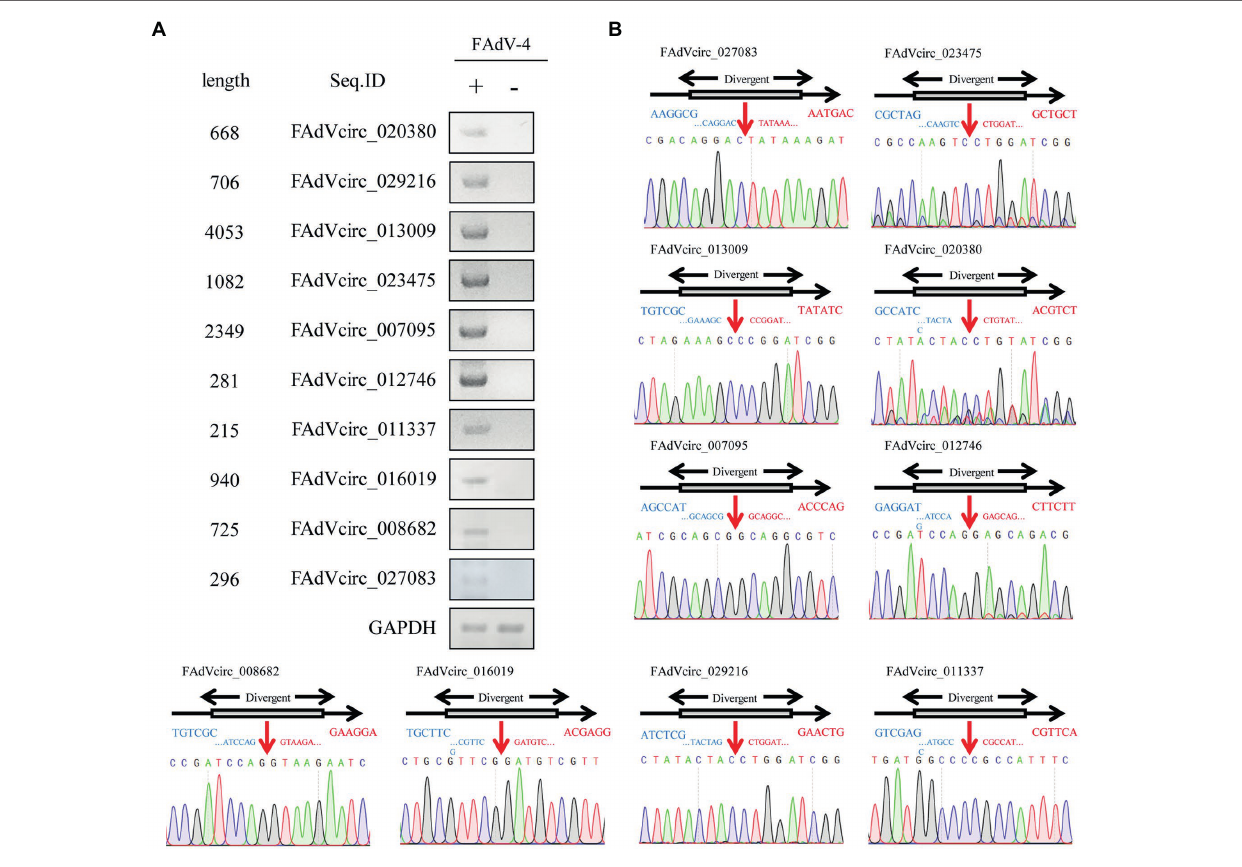
FIGURE 6 | Validation of FAdVcircRNAs. (A) FAdVcircRNAS were detected by semiquantitative RT-PCR using divergent primers. Ten FAdVcircRNAs (FAdVcirc_020380, FAdVcirc_027083, FAdVcirc_029216, FAdVcirc_013009, FAdVcirc_023475, FAdVcirc_007095, FAdVcirc_012746, FAdVcirc_011337, FAdVcirc_016019, and FAdVcirc_008682) were selected for validation. (B) The expected PCR product was Sanger sequenced and the junction site was confirmed. The red arrow on the DNA sequencing peak diagram represents the junction site for the viral